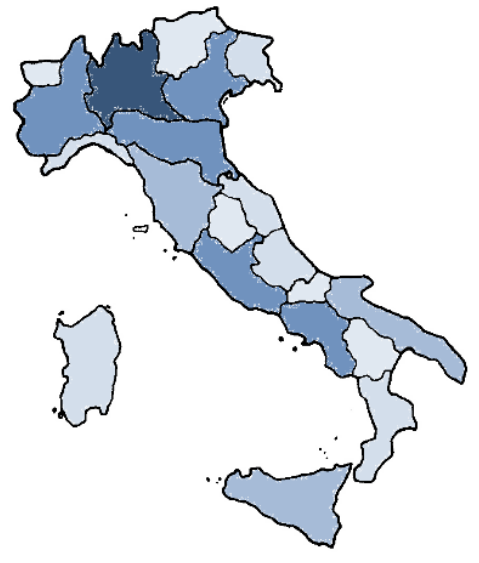
Figure 1. Cumulative incidence of coronavirus disease 2019 (COVID-19) infections by Italian Region (data upload 17 January, 2021). The different colors indicate the density of ascertained cases: dark blue corresponds to a maximum level of contagion, and light blue, a minimum level of conta- gion.